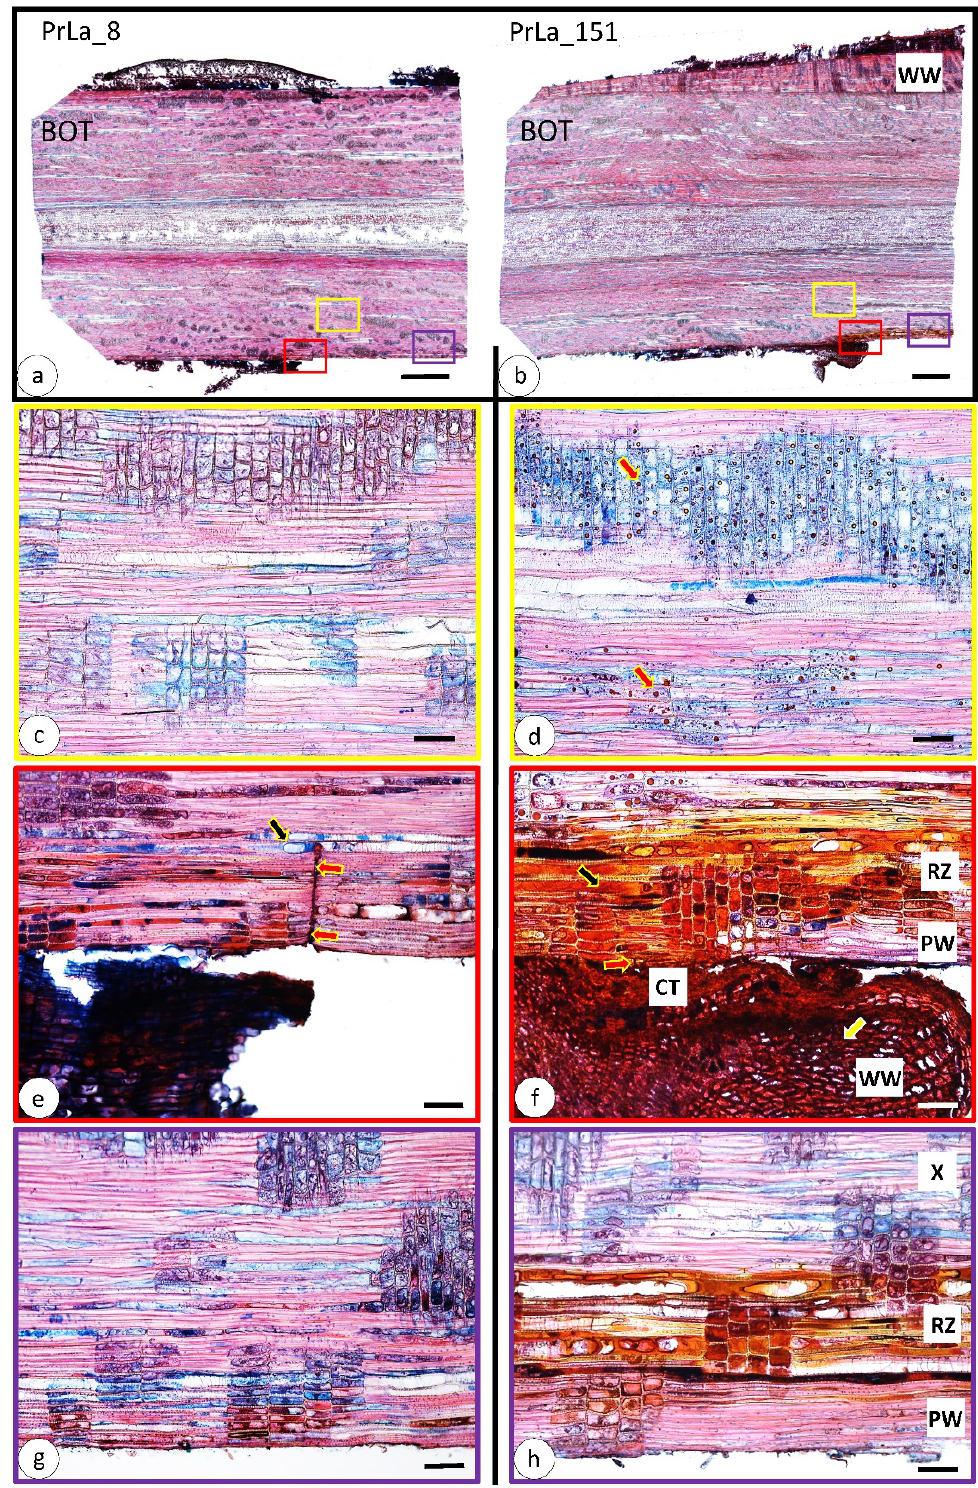
Figure 4. Cherry laurel ( Prunus laurocerasus ), radial section: ( a ) sample PrLa_8, bottom part (BOT), 8 days after injury; ( b ) sample PrLa_151, bottom part (BOT), 151 days after injury; ( c and d ) comparison of inner part in 8 and 151 days; ( e and f ) comparison of wound wood (WW), callus tissue (CT), protection wood (PW) and reaction zone (RZ) formation in 8 and 151 days; ( g and h ) exposed wood in 8 and 151 days after wounding with protection wood (PW), reaction zone (RZ) and sound secondary xylem (X). ROIs are marked by colour frames of the figures. Scale bars: a and b = 2 mm; b, c, d, e, f, g and h = 100 µm.